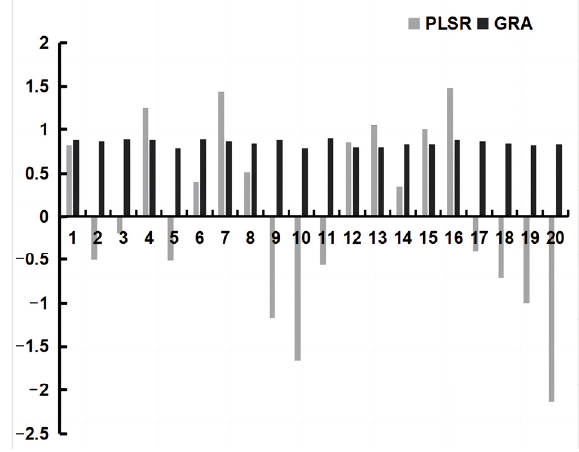
Figure 4. GRA and PLSR results for WDD compounds. GRA = Gray relation analysis; PLSR = Partial least squares regression; WDD = Wendan Decoction. Table 5. GRA and PLSR results for WDD compounds.